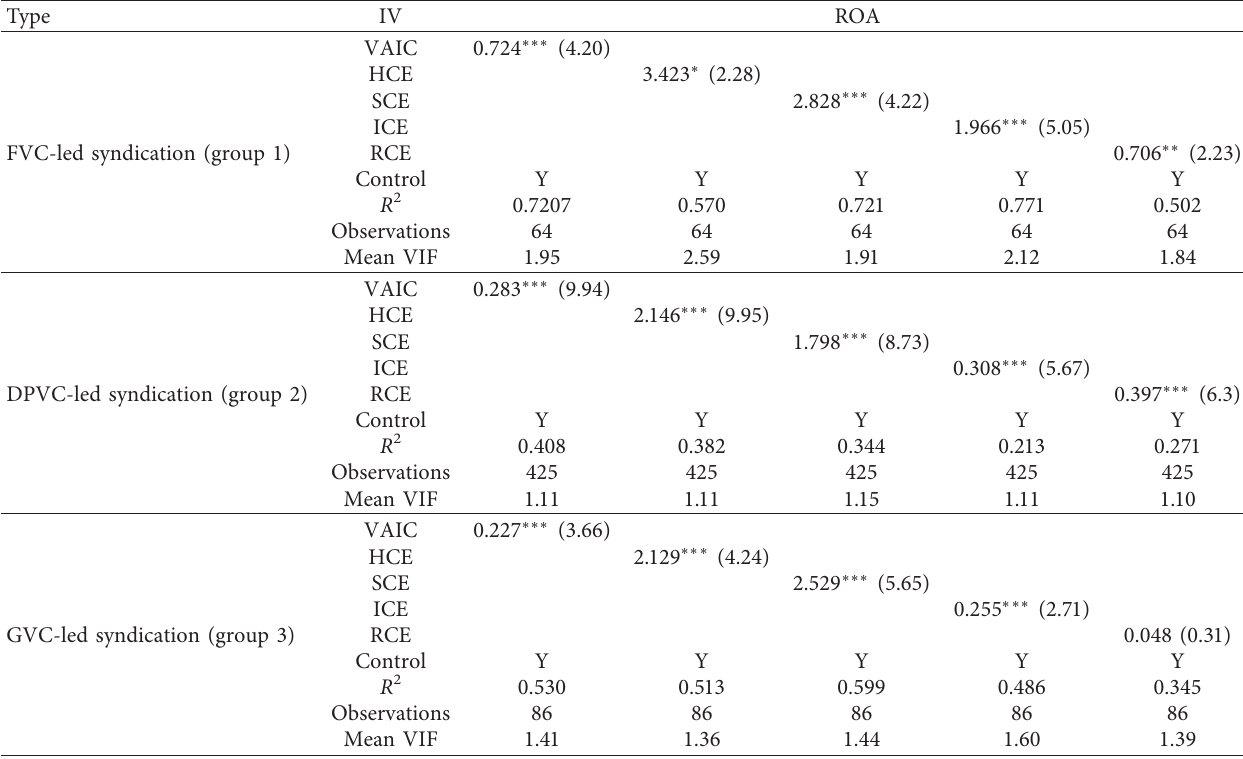
Table 6: Test results of VCS leading firm background heterogeneity.